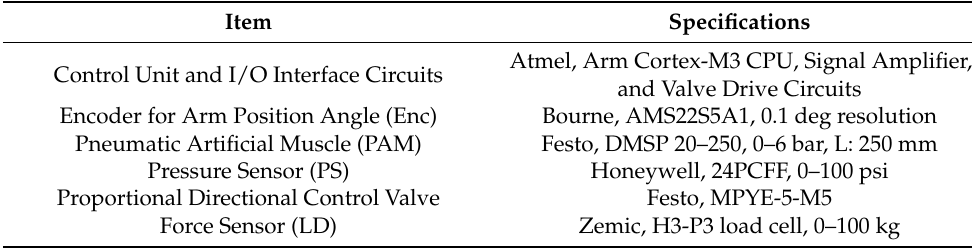
Figure 5. Hardware implementation and structure of 1DoF rotating arm PAM testbed. Table 1. Hardware specifications of 1 DoF rotating arm PAM testbed. Item